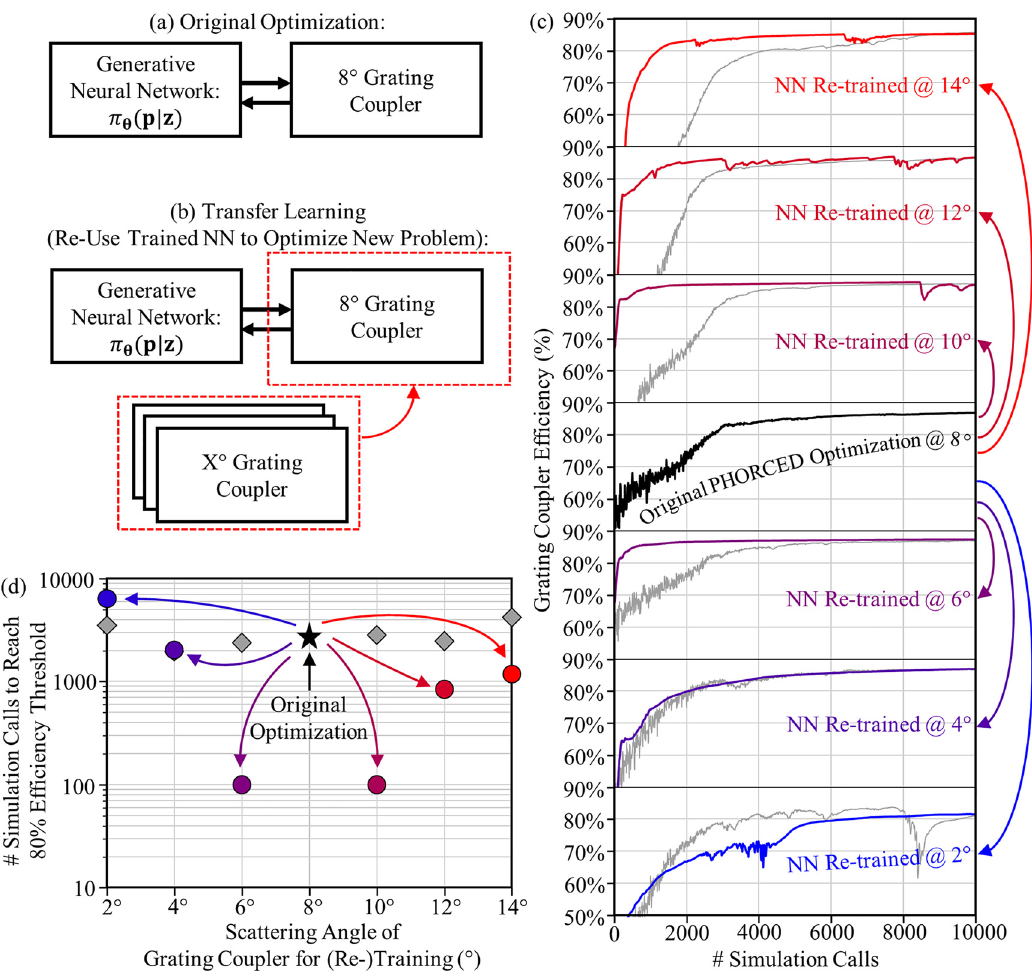
Figure 3: Transfer learning applied to grating coupler design yields accelerated convergence rate in optimization. The original PHORCED optimization from Figure 2(b) is qualitatively depicted as a block diagram in (a) for comparison with the transfer learning approach in (b). Here, we exchange the 8 ◦ grating coupler merit function with an alternative grating coupler angle for retraining. Optimization progressions as a function of the number of simulation calls for each of the retraining sessions are shown in the blue/red curves of (c). Control optimizations where transfer learning was not applied are plotted in gray for comparison. In (d) we plot the number of simulation calls for each optimization from (c) to reach 80% grating coupler scattering efficiency, with blue/red colored arrows and dots indicating applications of transfer learning and gray diamonds indicating the control